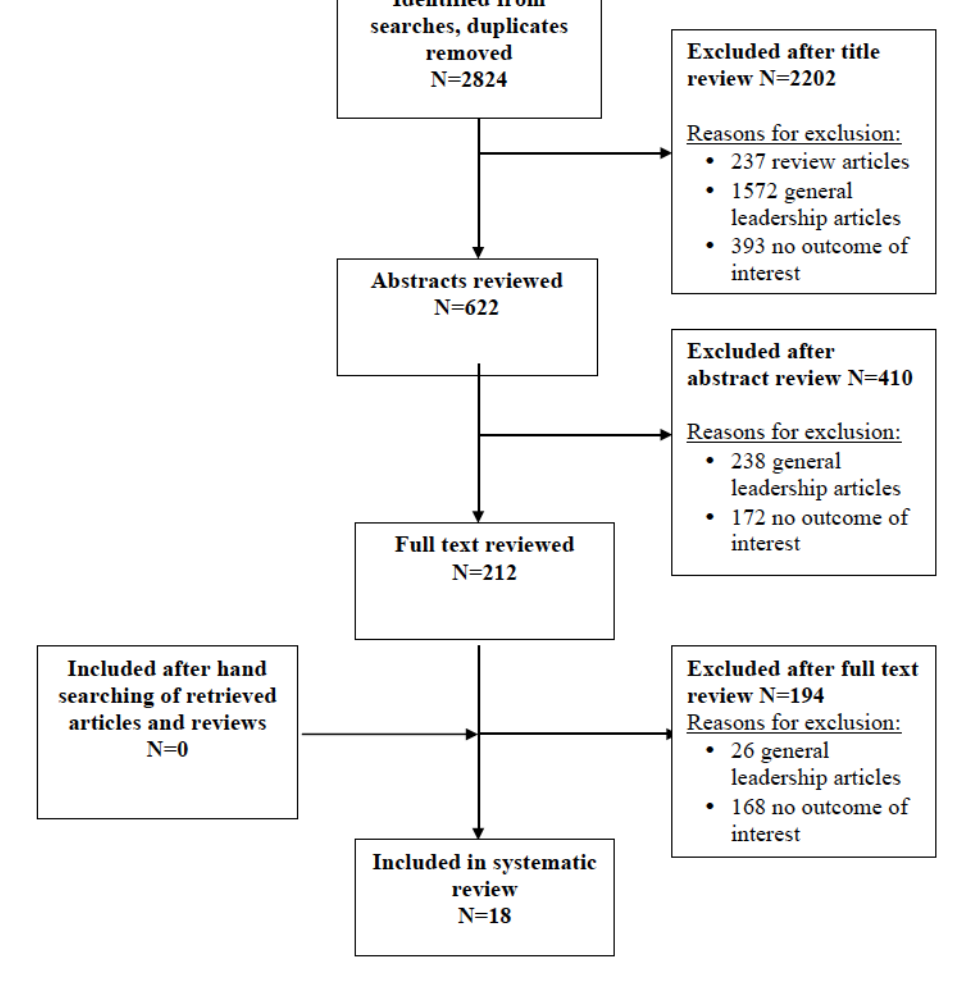
Figure 1. Prisma Figure 1. Prisma flowchart.